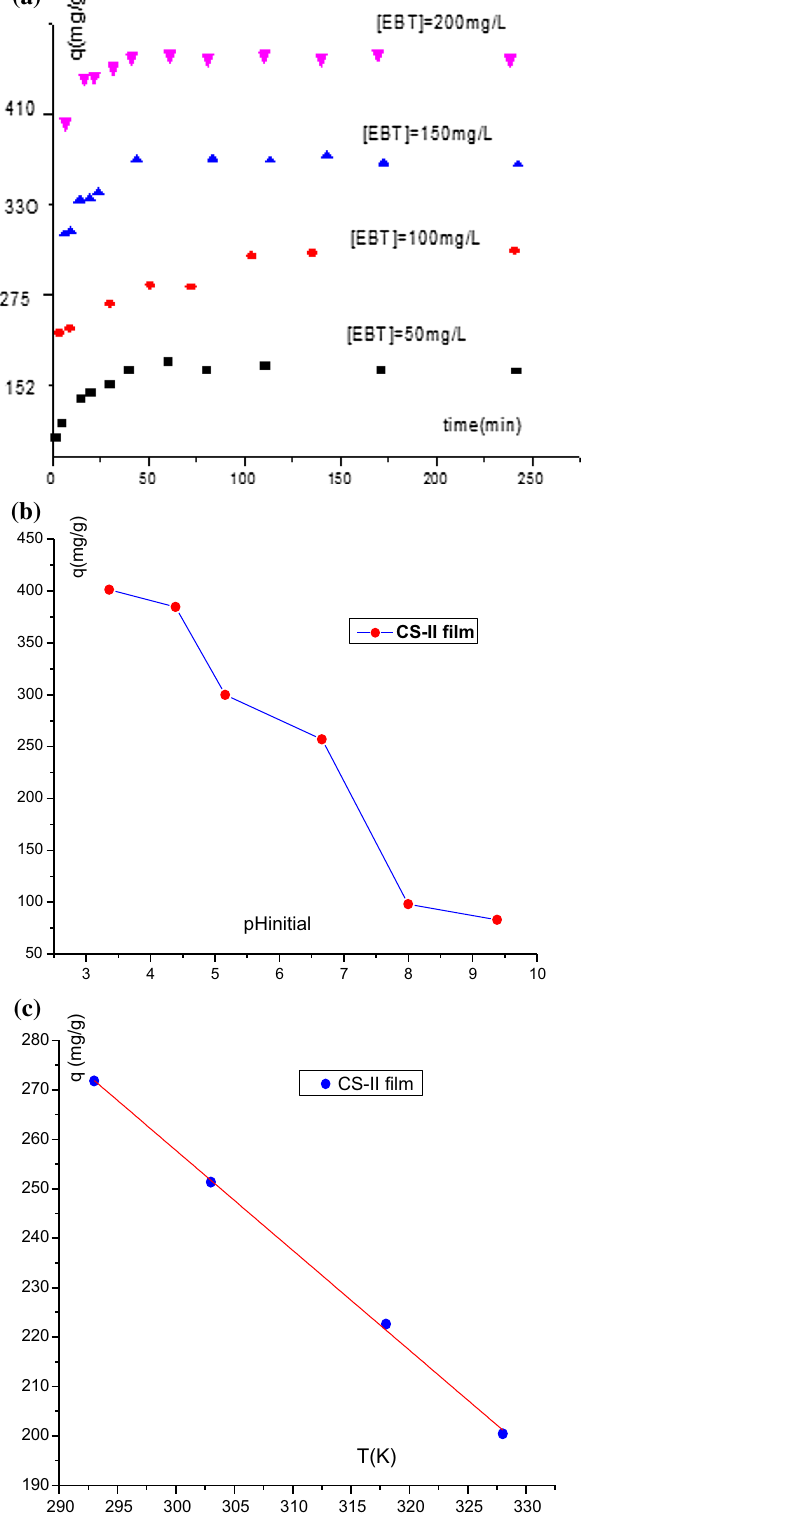
Fig. 5 Effect of a contact time and initial dye concentration, b pH c temperature on adsorption